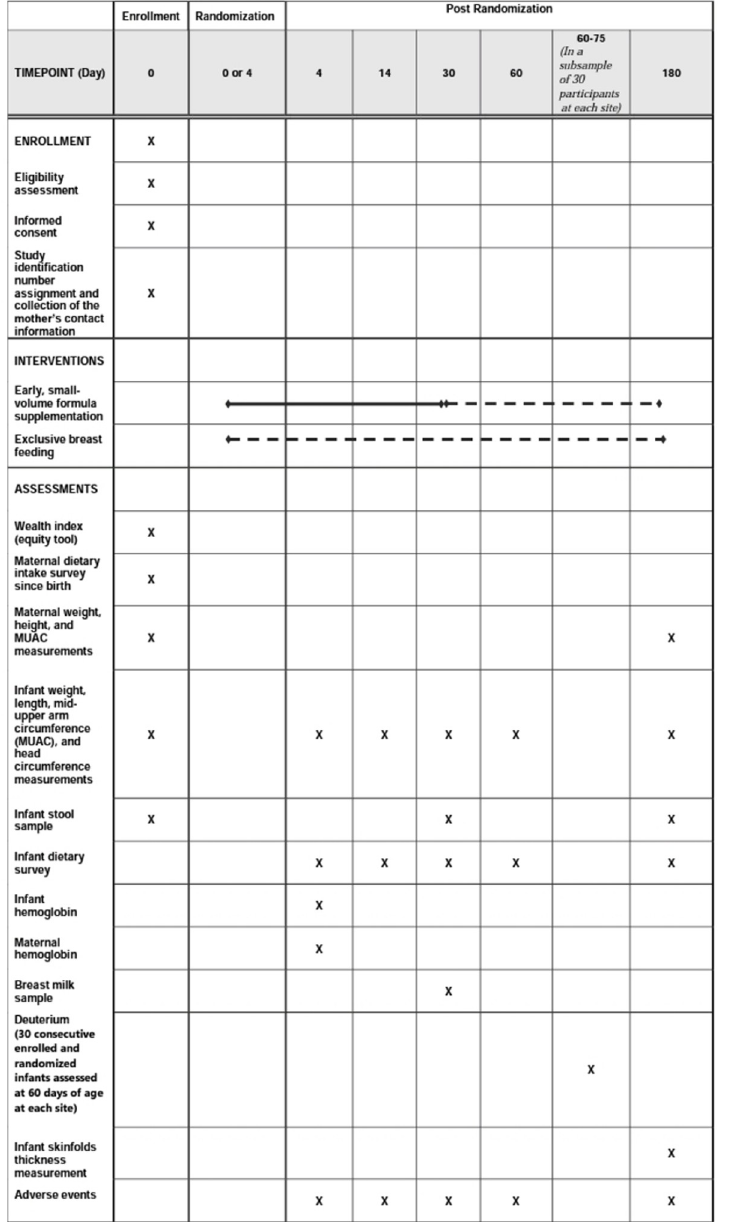
Fig 1. Schedule of enrolment, interventions, and